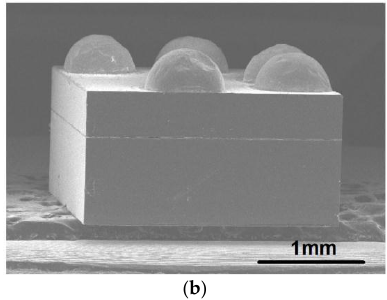
Figure 2. SEM images of MEMS accelerometers with TSVs [21]. ( a ) Bird’s eye view of bonded MEMS wafer and cap wafer with part of cap wafer cleaved away; ( b ) The MEMS accelerometer package after solder-bumping and dicing.